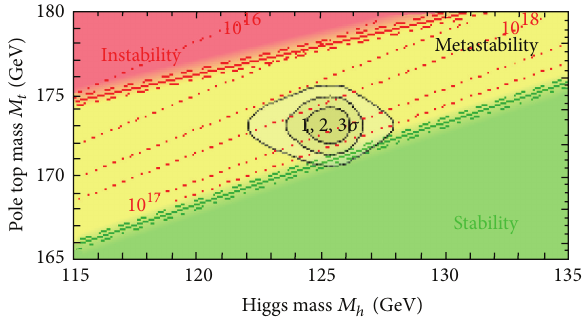
Figure 11: Measured value of the top mass and preferred range of 𝑚 ℎ as revealed by the present searches at the LHC, compared to the regions corresponding to absolute stability, metastability, and instability of the SM vacuum [53]. The three boundaries lines correspond to 𝛼 𝑠 (𝑀 𝑍 ) = 0.1184 ± 0.0007 , and the grading of the colors indicates the size of the theoretical errors. The dotted contour lines show the instability scale Λ in GeV assuming 𝛼 𝑠 (𝑀 𝑍 ) = 0.1184 .